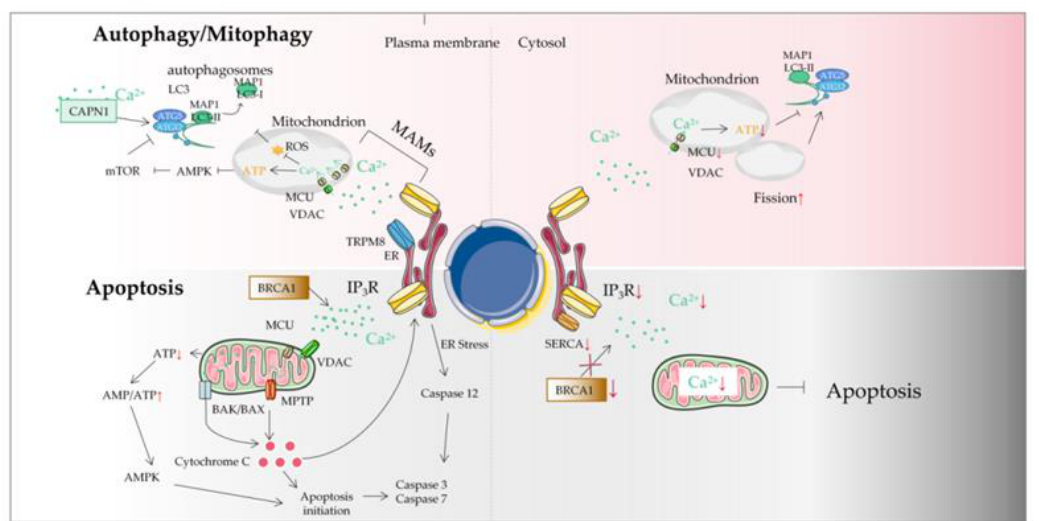
Figure 4. The autophagy/mitophagy and apoptosis of tumor cells. Autophagy plays a key role in maintaining cellular homeostasis. Autophagy disorder destroys normal physiological processes and can lead to cancer. Ca 2+ can inhibit autophagy through an IP3R- or ER-mediated manner. Some mitochondrial Ca 2+ transporters are also involved in autophagy and mitophagy regulation. Autophagy plays two roles in a tumor: a protective role in the early stages of tumor and the promotion of tumor growth in advanced stages. Tumor cells may avoid apoptosis by reducing Ca 2+ influx into the cytoplasm. It can be achieved by downregulation of the expression of Ca 2+ channels in the plasma membrane or by reducing the effectiveness of the signal pathways that activate these channels. This protective measure will greatly reduce the response of Ca 2+ overload to pro-apoptotic stimulus, thus impairing the effectiveness of mitochondrial and cytoplasmic apoptotic pathways in tumor cells. Another mechanism is that tumor cells adapt to the reduction of Ca 2+ in ER, without inducing the pro-apoptotic ER stress response usually accompanied by ER Ca 2+ imbalance. ER, endoplasmic reticulum; MAM, mitochondrial-associated ER membrane; MCU, mitochondrial calcium uniporter; MPTP, mitochondrial permeability transition pore; ROS, reactive oxygen species; TRPM8, transient receptor potential cation channel subfamily M member 8; VDAC, voltage-dependent